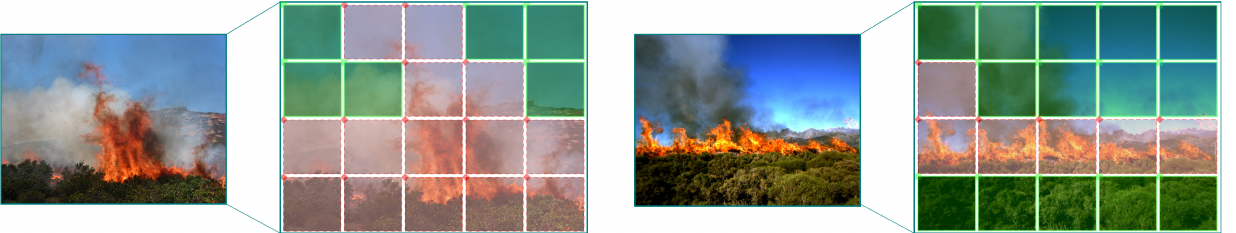
Figure 4. The process of image tessellation on two selected images from the CFDB dataset is illustrated. The configuration of 5 × 4 sub-images per image is shown. Labeling of sub-images is shown in different colors: (i) the image with a red diamond in the upper left corner represents a sub-image with fire, and (ii) the image with a green square in the upper left corner represents a sub-image without fire. The process results in a balanced number of fire and not-fire